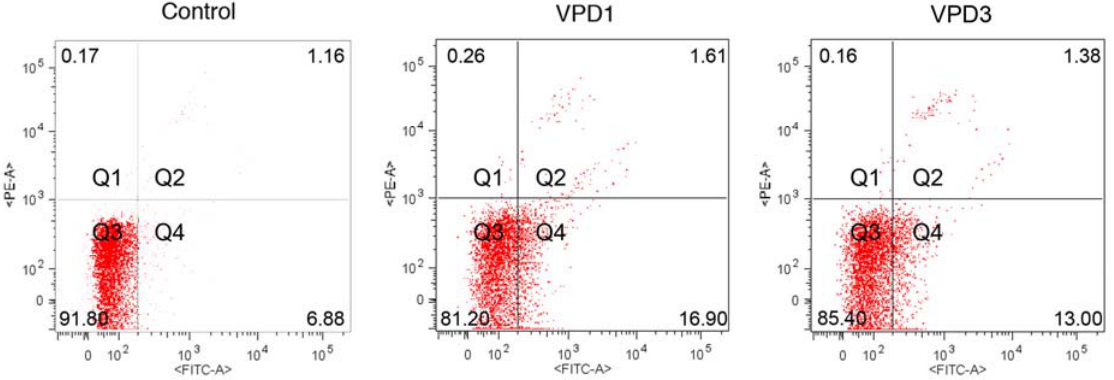
Figure 6. Representative dot plots showing fractions of healthy (Q3), apoptotic (Q4), and dead (Q1 and Q2) cells after 24 h exposure to 20 μ M of